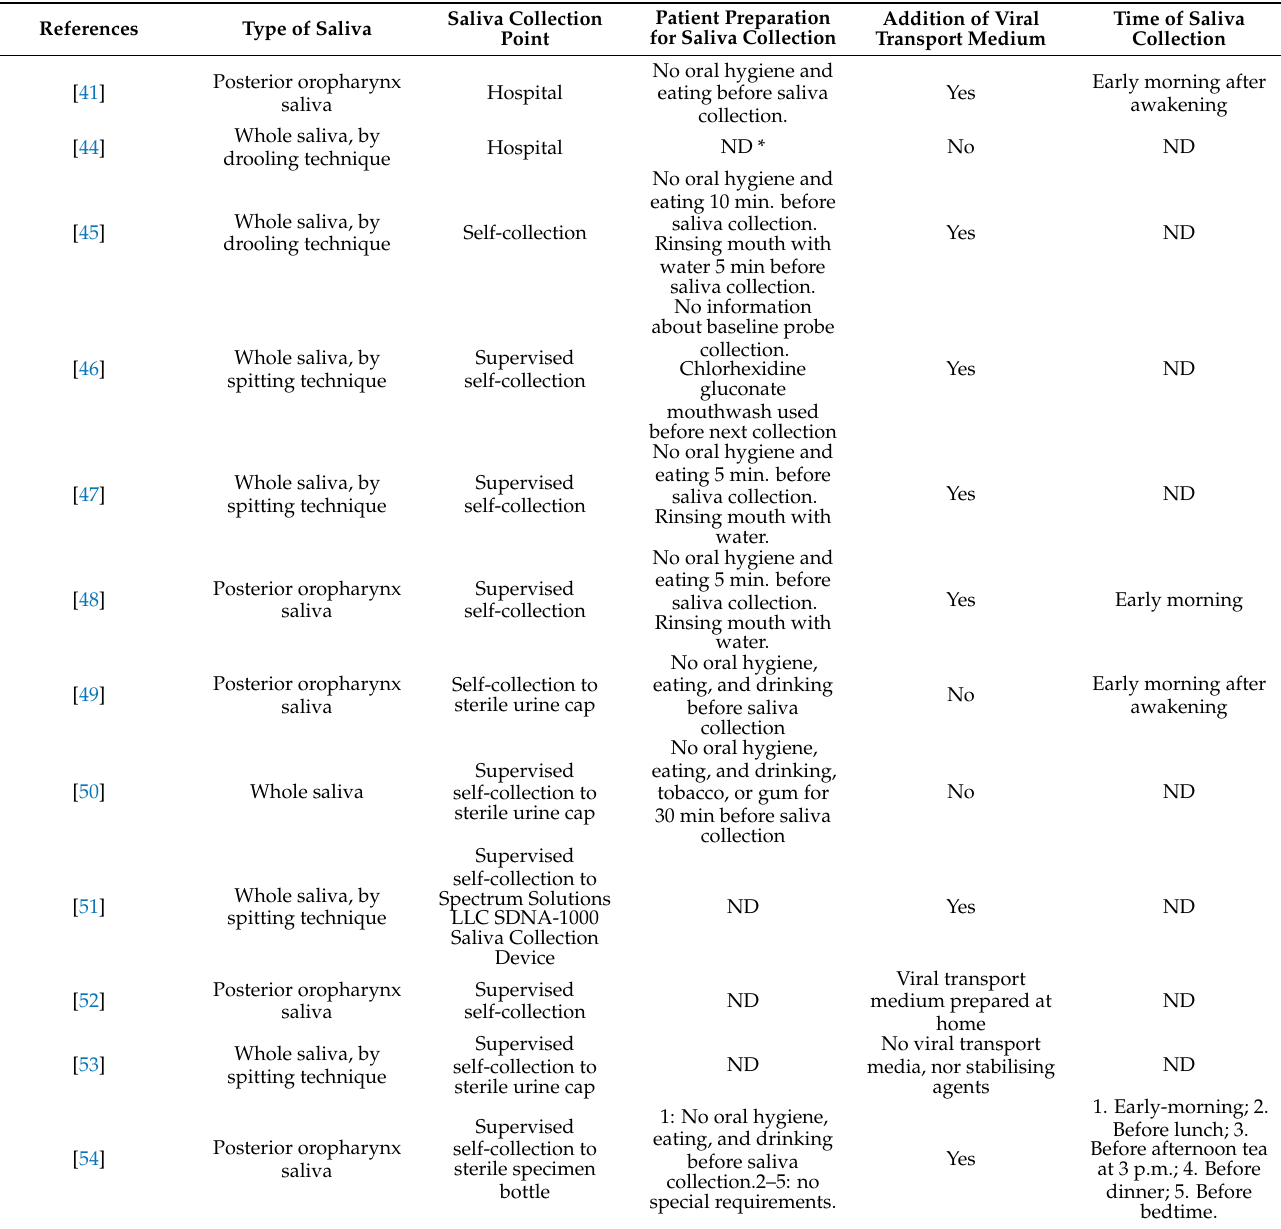
Table 4. The comparison of technical and pre-analytical preparation of patients for SARS-CoV-2 salivary